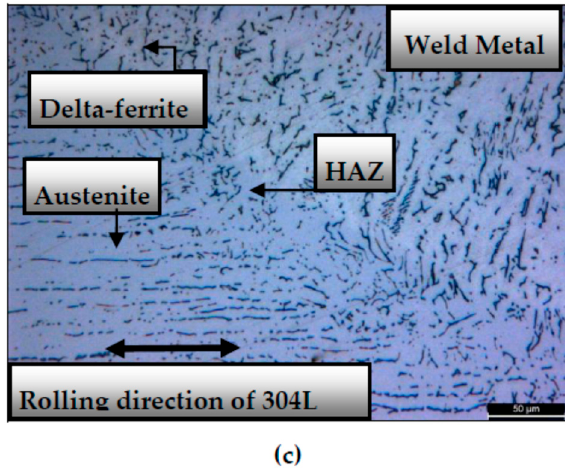
Figure 10. Microstructures of sample welded by ER2209 TIG Rod ( a ) 420 side, HAZ and weld metal; ( b ) weld metal; ( c ) weld metal, HAZ and 304L side (scale: 100 µm).